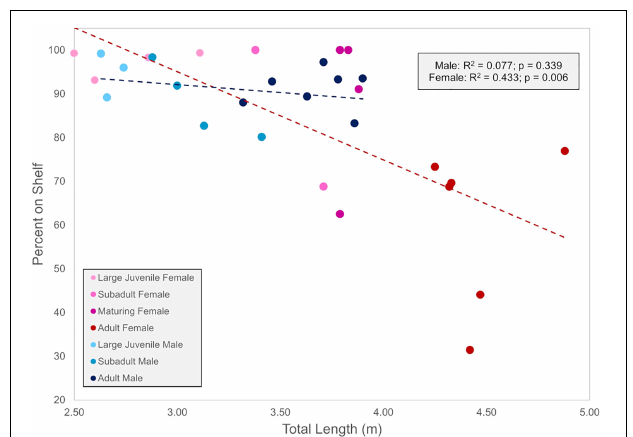
FIGURE 3 | Proportion of on-shelf locations for all white sharks with a tracking duration longer than 200 days based on regularized daily locations provided by the hSSM derived from SPOT and acoustic locations. Size ranges for life stages are found in the Section “Life Stage Classification.” Lines are best fit regression